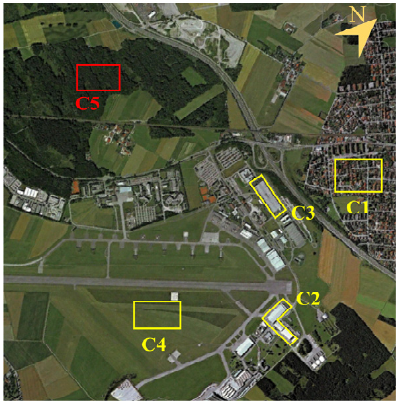
Figure 14. Optical image of Oberpfaffenhofen, Germany.